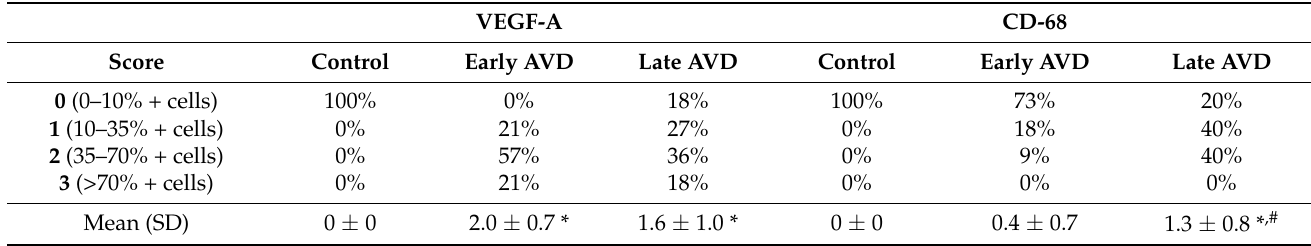
Table 3. VIC relative expression of angiogenesis and